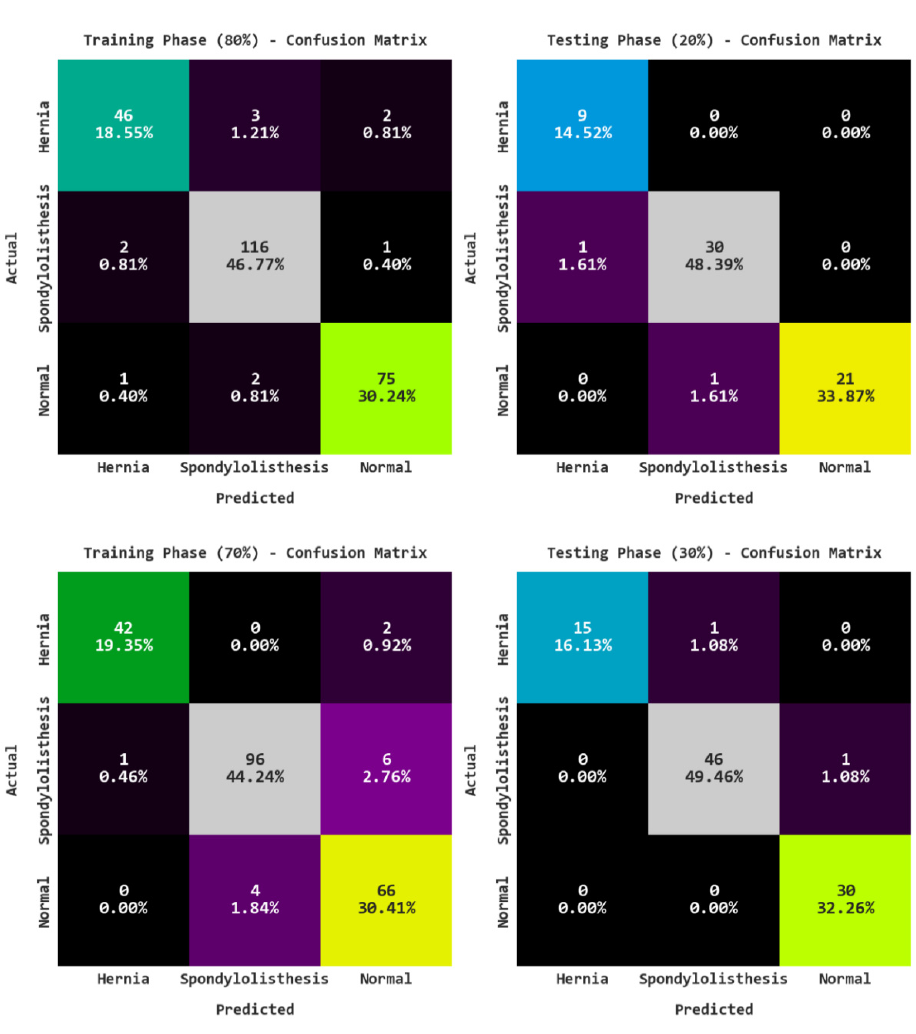
Figure 3. Confusion matrices of ARAC ‐ AOADL model.